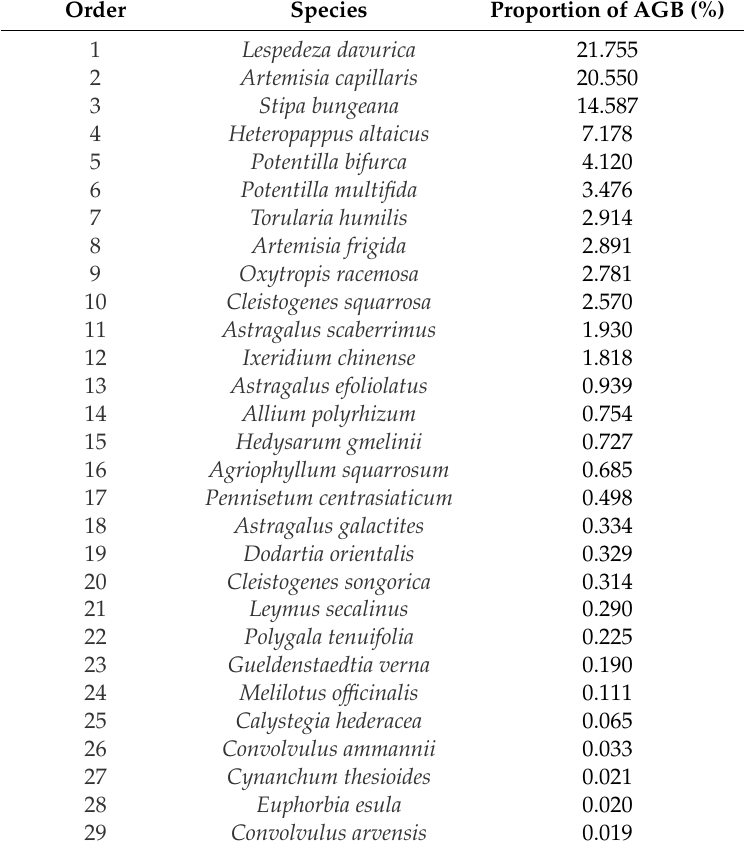
Table 1. Proportion of aboveground biomass (AGB) of species in the community. Order Species Proportion of AGB